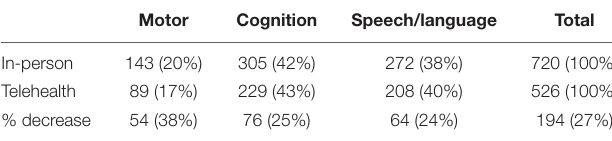
TABLE 3 | Implementation of NMT by domain for in-person versus